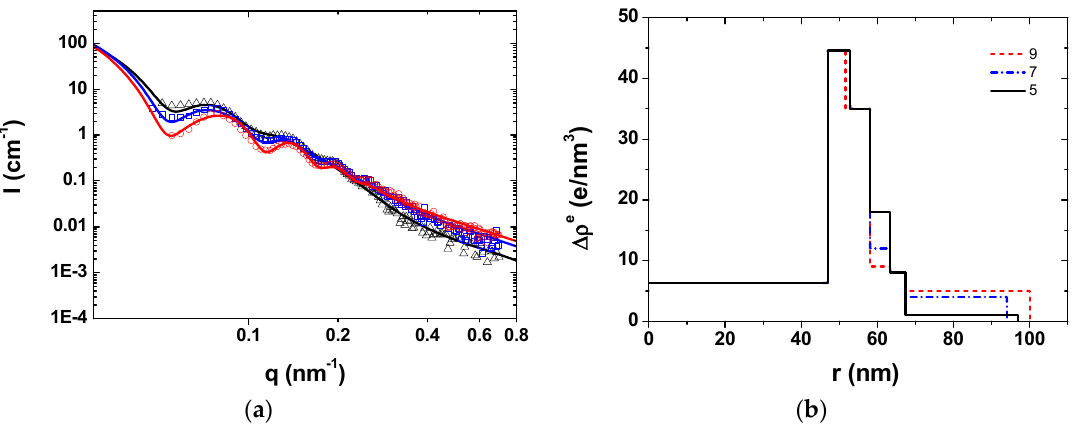
Figure 9. ( a ) Scattering intensity curves of PAA-PAH-PAsp triple-layer modified SPBs at pH 5 ( ∆ , black), 7 ( □ , blue) and 9 ( ○ , red). Solid lines are the fitting curves; ( b ) The radial profile of excess electron density of PAA-PAH-PAsp triple-layer modified SPBs at different pH (C NaCl = 10 mM).